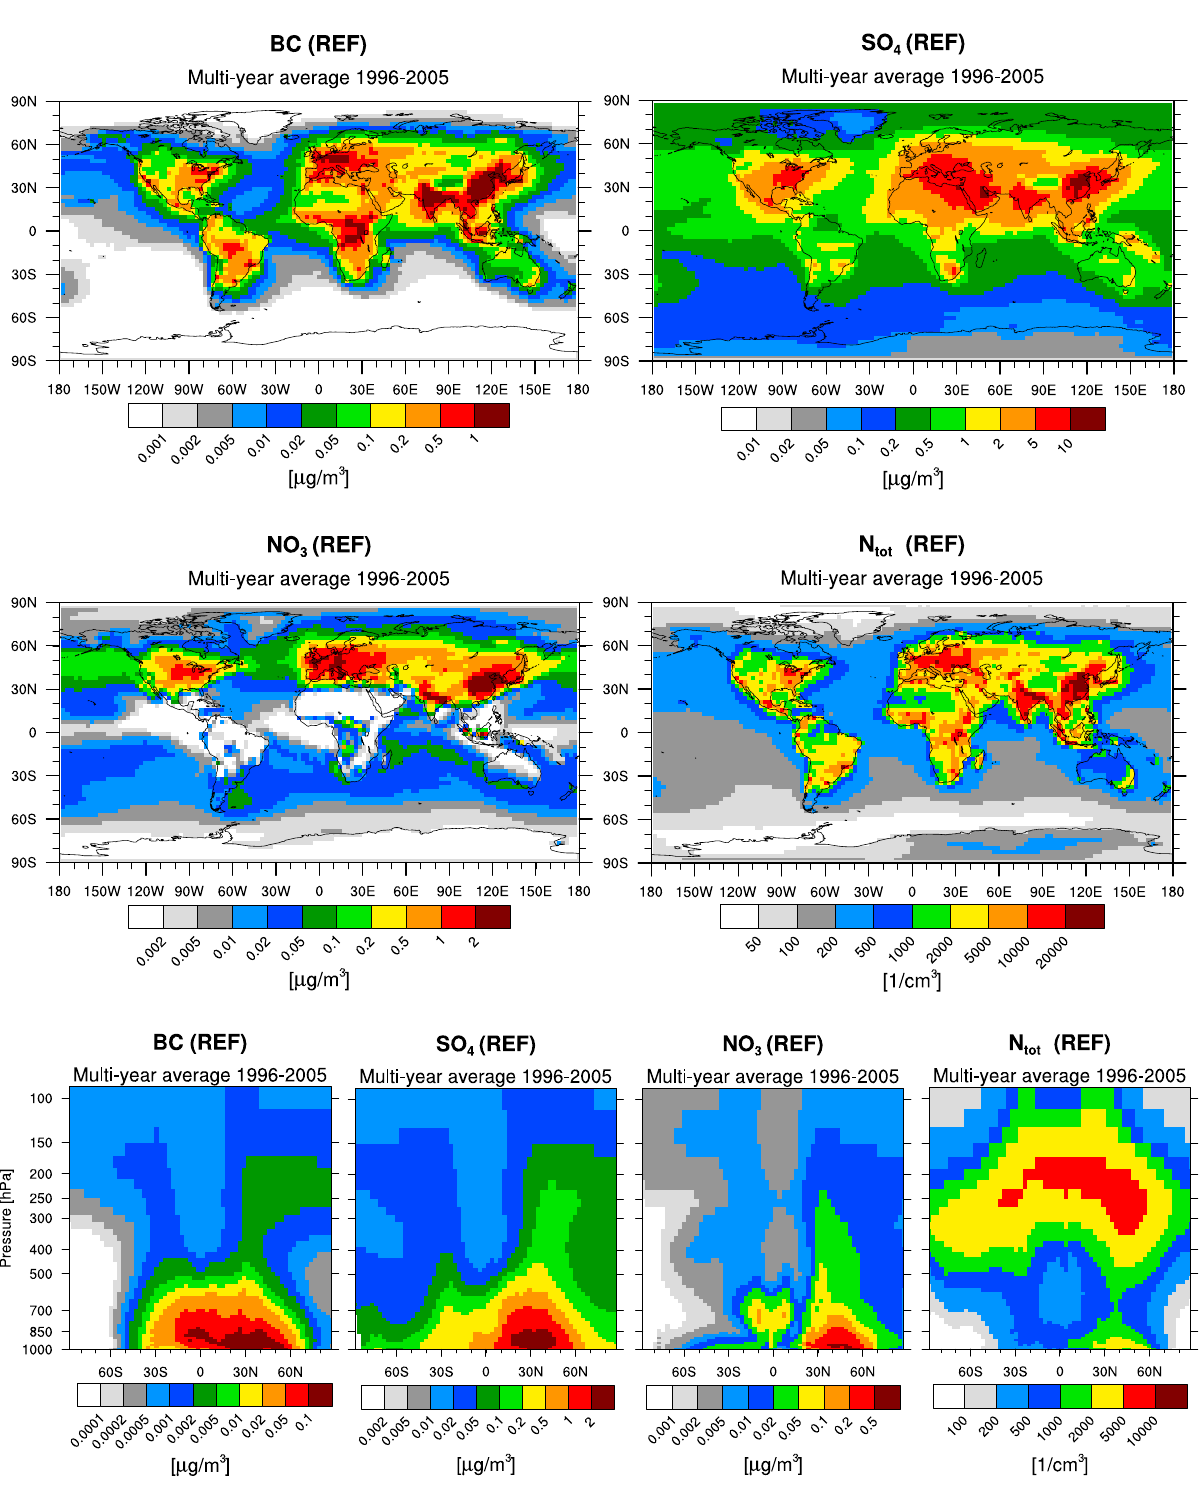
Fig. 2. Multi-year average (1996–2005) surface-level concentrations of BC (top row, left), SO 4 (top row, right), NO 3 (middle row, left) and fine particle ( . 1µm, sum of the Aitken and accumulation mode) number concentration (middle row, right) for the reference (REF) simulation. Corresponding zonal mean plots are depicted in the bottom row (the 100hPa level corresponds to an altitude of about 16km).